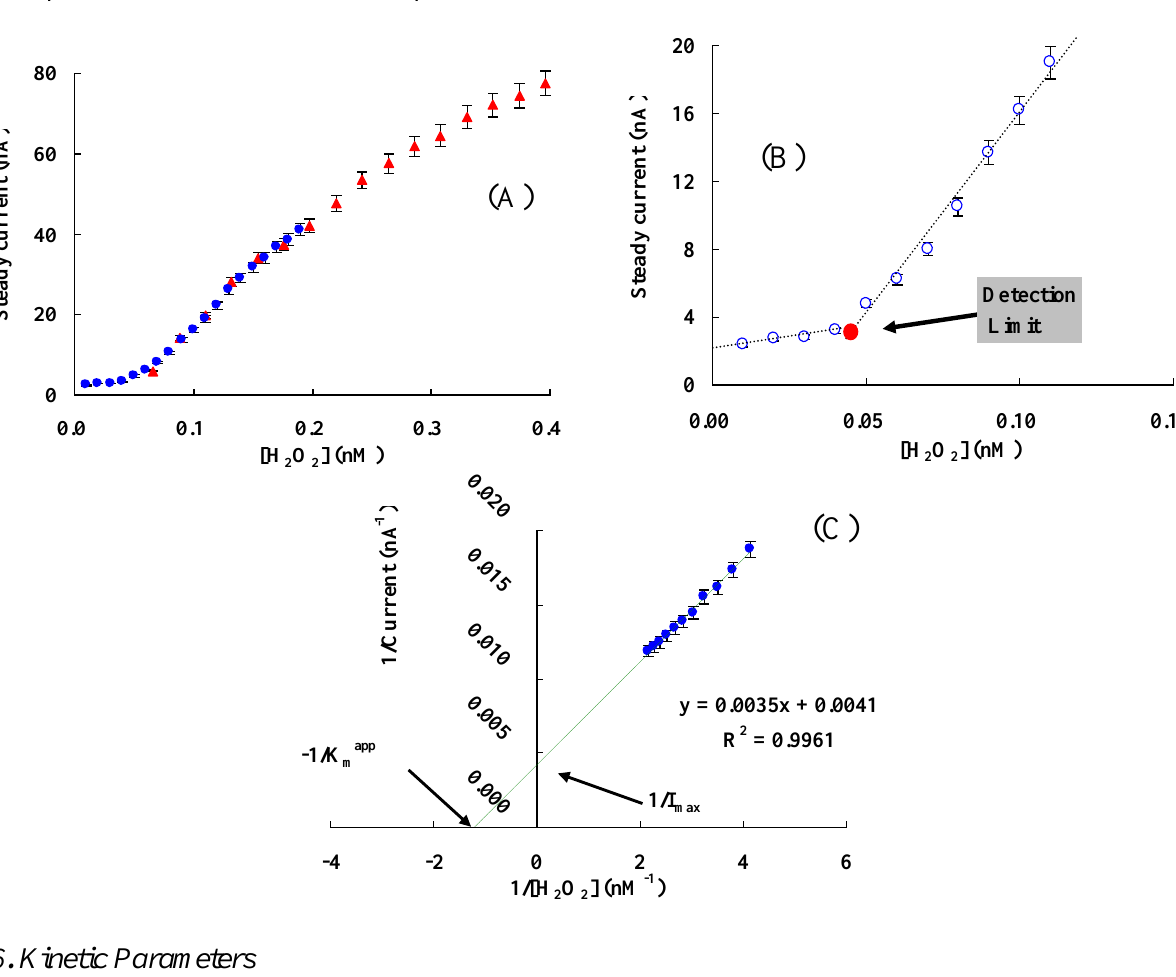
O ] in the process of successive additions 2 2 O in 5 mL of 50 mM PBS (pH 7.0) at the applied 2 2 O detection limit for 2 2 O ] 2 2 O in 5 mL of 50 mM PBS 2 2